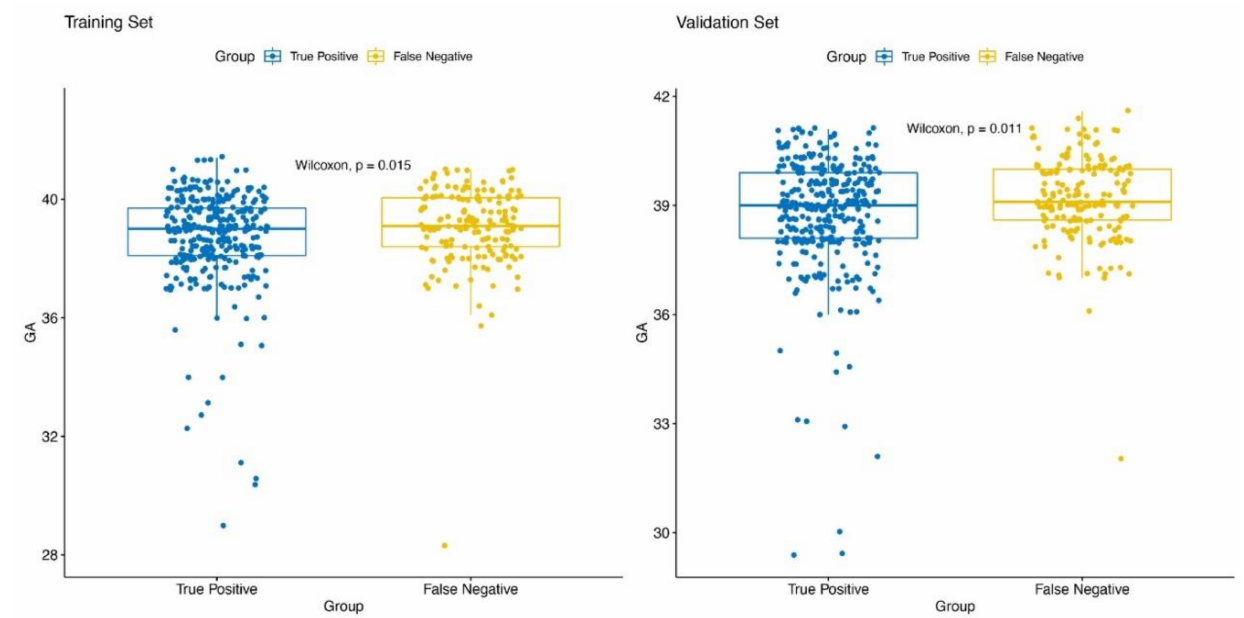
Figure 6. Box-and-whisker plots of gestational age between small for gestational age fetuses truly predicted by our model and not predicted by our